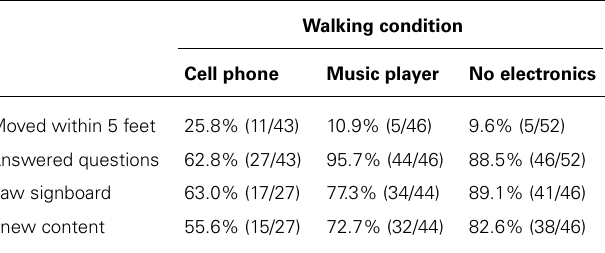
Table 1 | Measures of behavior and awareness based on cell phone use in Study 1: the signboard. Walking